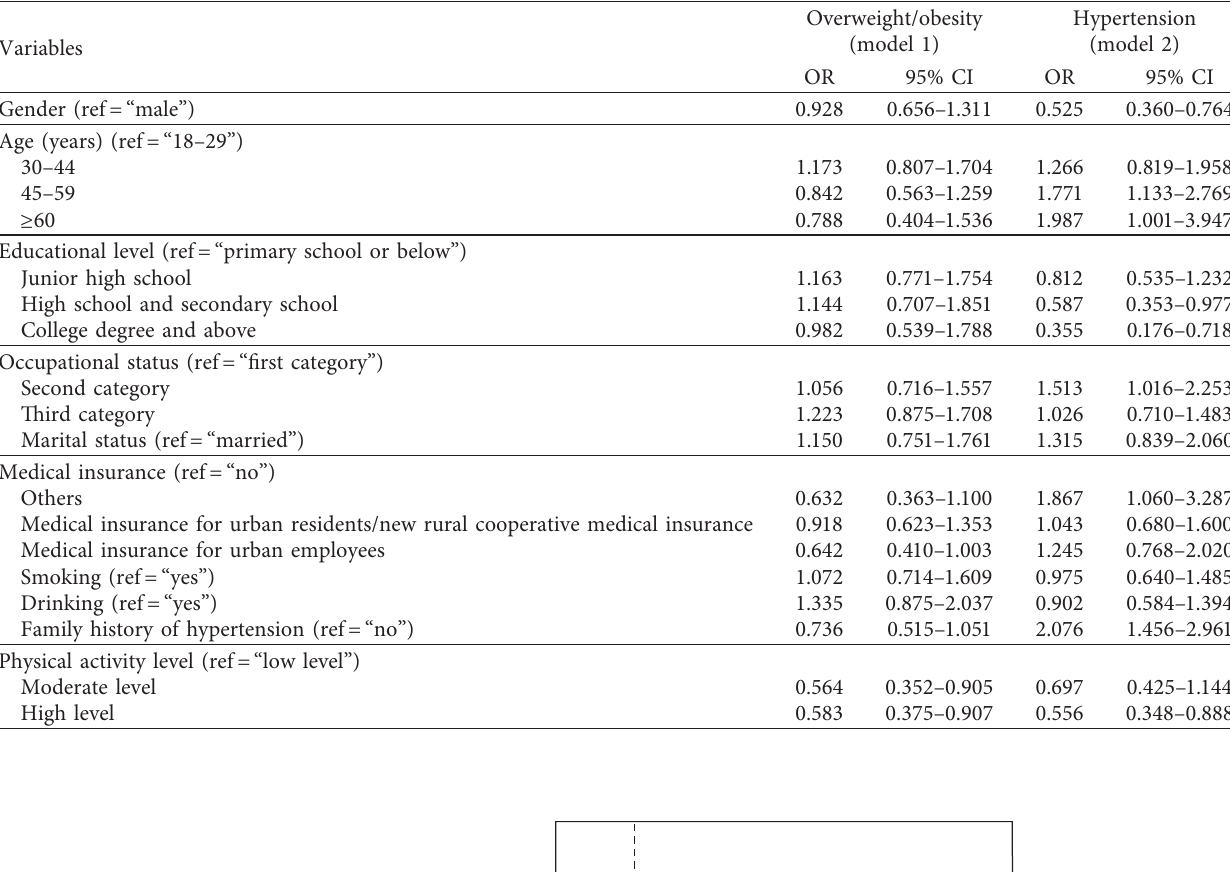
Table 3: Multivariable analysis of the effects of physical activity on overweight/obesity and hypertension.